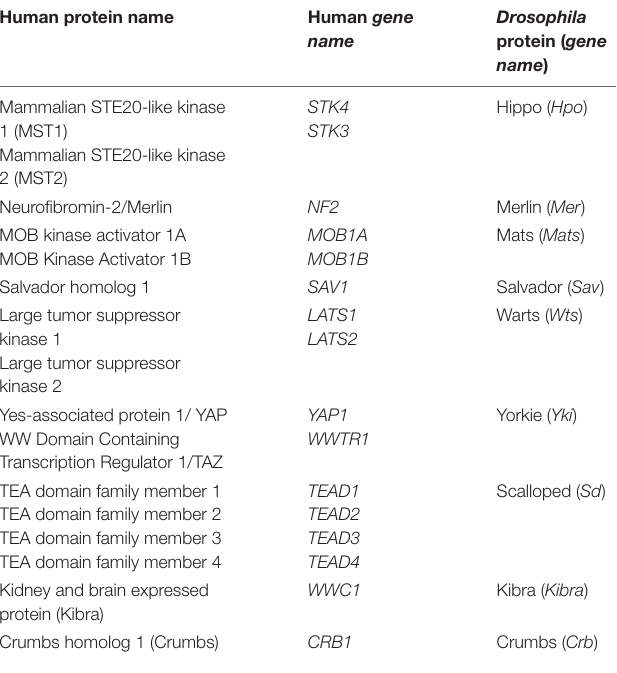
TABLE 1 | List of key Hippo pathway genes in fruit fly ( Drosophila melanogaster ) and the respective orthologs in